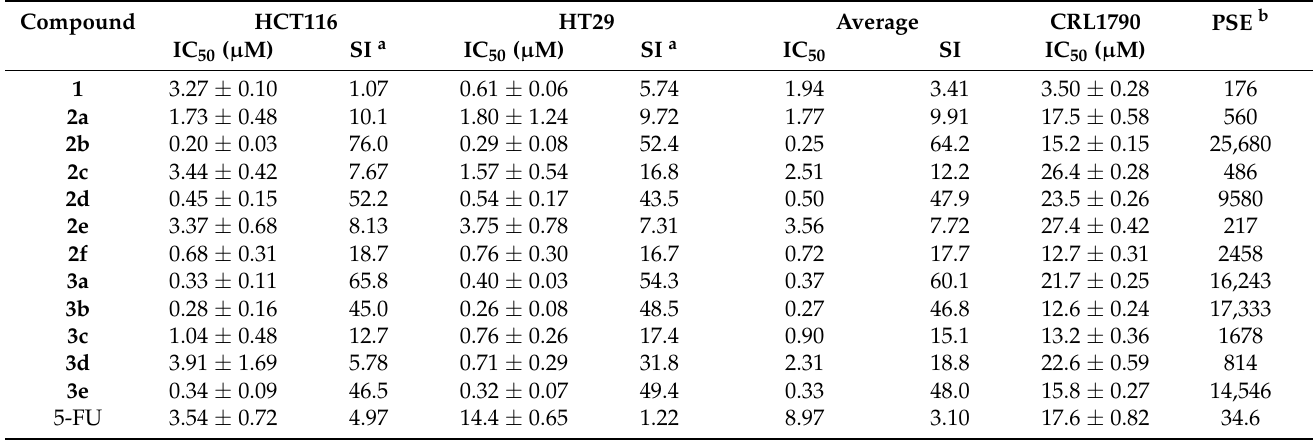
Table 1. Evaluation of 1 , 2a – f , and 3a – e against human HCT116 and HT29 colon cancer cells and human CRL1790 colon